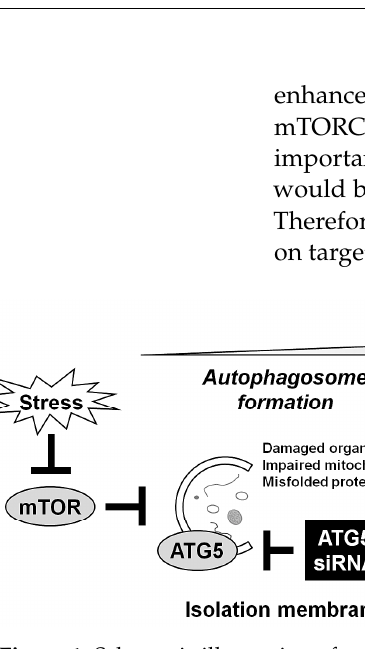
Figure 1. Schematic illustration of autophagy regulation. Autophagy is an intracellular mechanism by self-digestion and recycling damaged components in response to various stresses, including nutrient deprivation. Under stress conditions, mTOR is suppressed, and autophagy-related proteins are activated for the formation, growth, and closure of the isolation membrane, in which ATG5 is essential. The ATG5 is required for the lipidation of LC3 from LC3-I to LC3-II. The LC3-II is the only protein that exists on the completed double-membraned isolation membrane, autophagosome. Then, matured autophagosomes that incorporate their own surplus protein and waste products are degraded by the fusion with the lysosome, leading to the production and reuse of amino acids. The p62/SQSTM1 serves as a link with LC3, and its labeled proteins are selectively degraded in this process. Monitoring this dynamic process, autophagic flux, is essential for understanding autophagy regulation. In this study, autophagy was inhibited at the early stage by RNAi using ATG5 siRNA or at the late stage by lysosomotropic chloroquine supplementation.